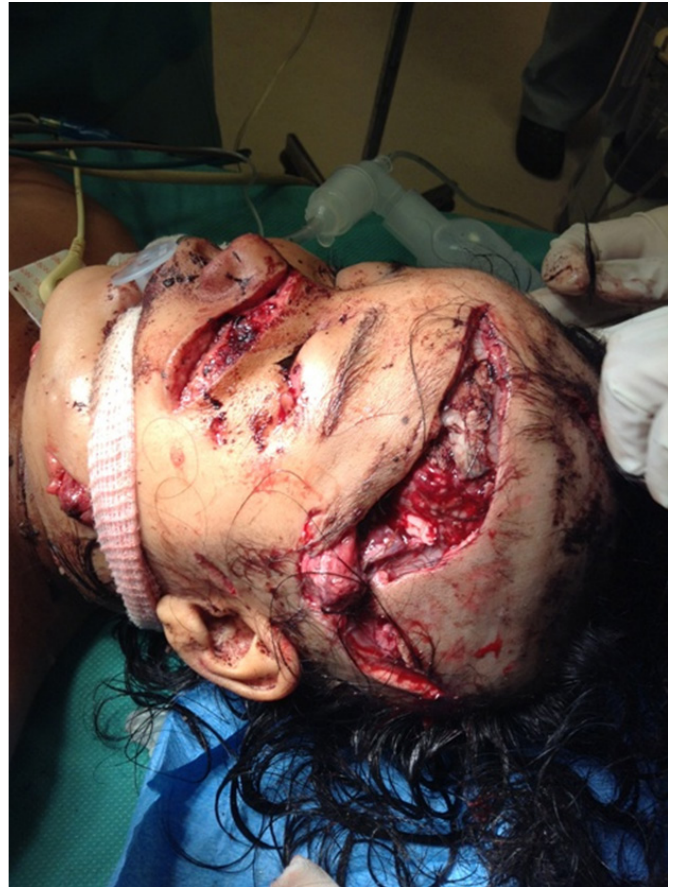
Figure 4. Child in the operating